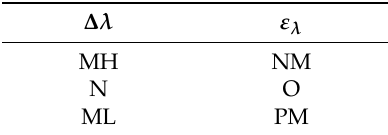
Figure 9. Factors of fuzzy control for ( a ) λ -shift and ( b ) P -shift. Table 1. Fuzzy Rule base of λ -shift.